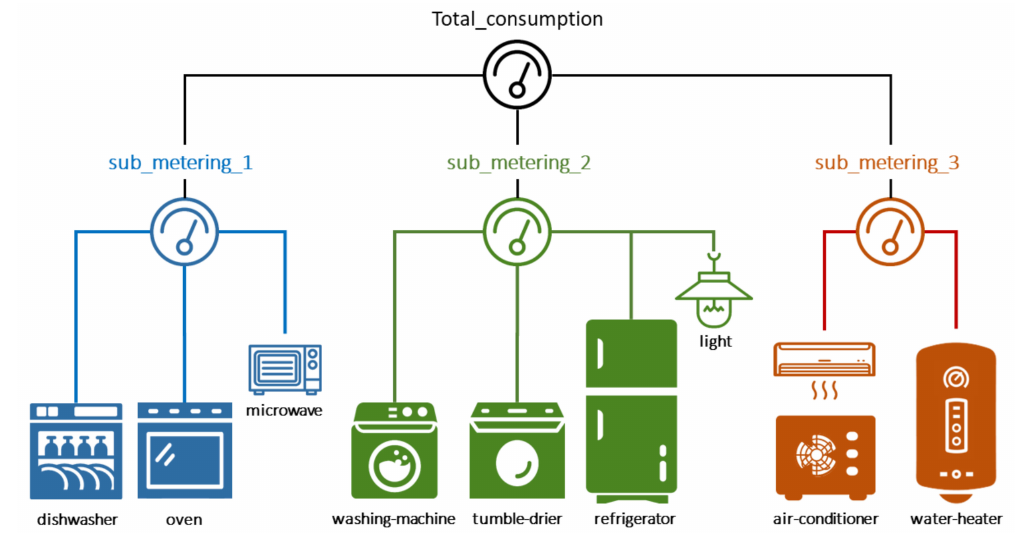
Figure 7. Schematic of electrical appliances and smart meter distribution.